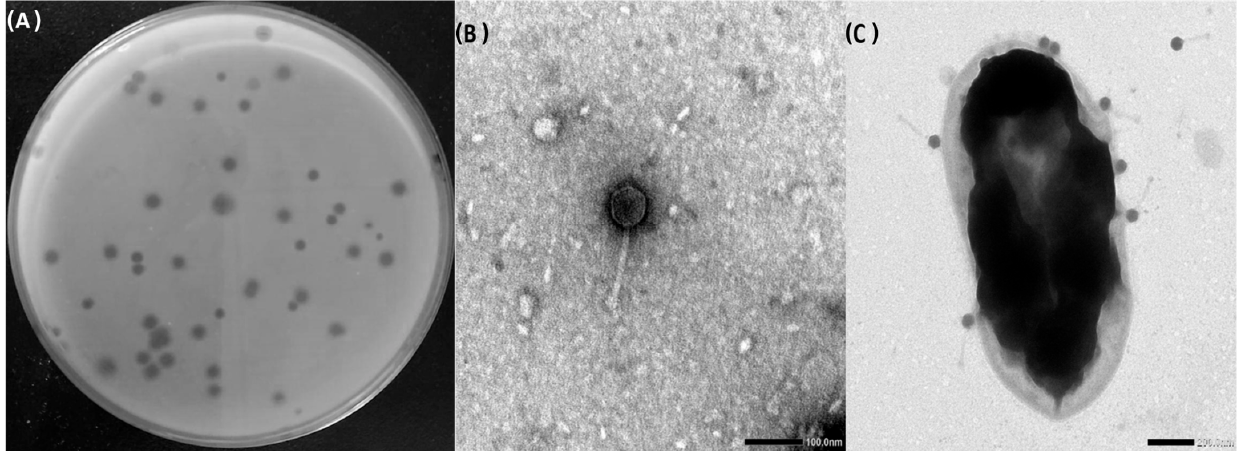
Figure 1. Morphology of phage ZCSE9. ( A ) Plaques of ZCSE9 against S. Typhi (NCTC 160), the scale bar 100 nm. ( B ) Phage ZCSE9 TEM micrographs. ( C ) Attachment of ZCSE9 to S. Typhi (NCTC 160); scale bar 200 nm.